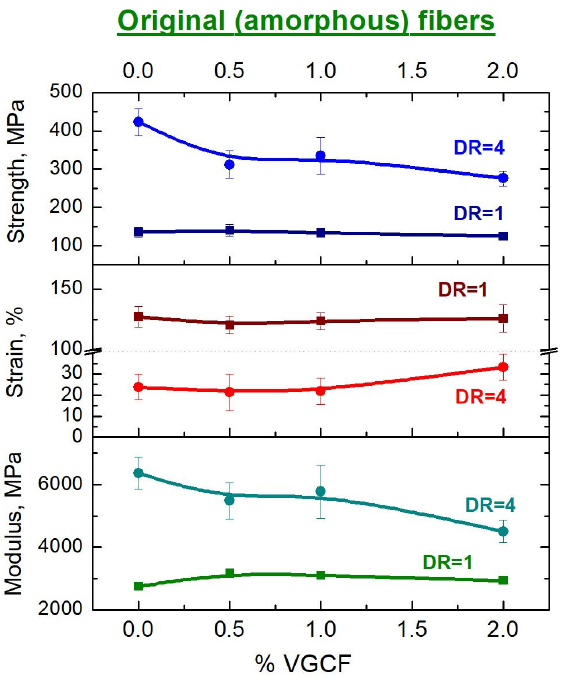
Figure 14. Dependences of the mechanical properties on the nanoparticle concentration in the pol- yimide matrix of the amorphous fibers before (DR = 1) and after (DR = 4) orientational drawing.